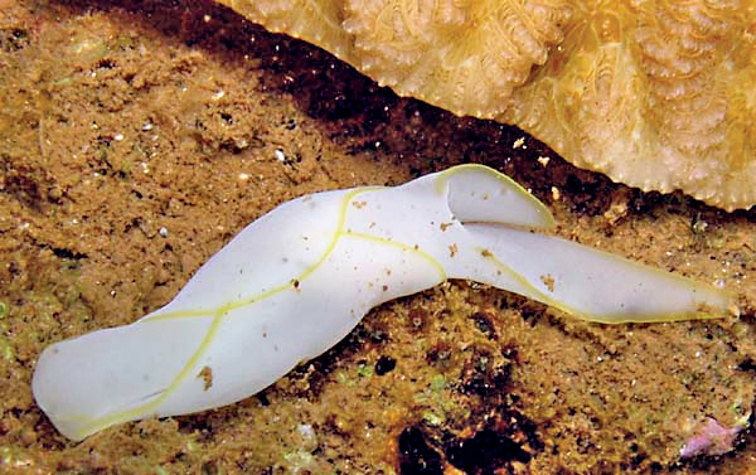
Chelidonura electra, 20–25 mm, Mayotte, photo: P Bidgrain.